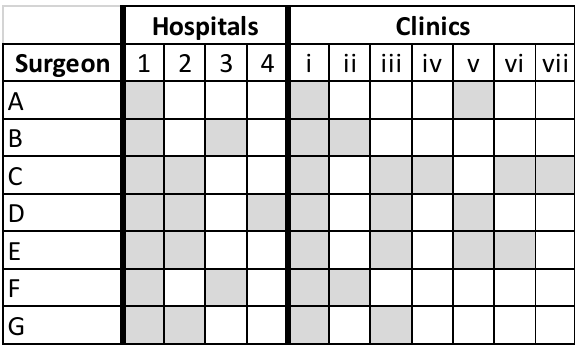
Figure 1. Neurosurgeon practice matrix.